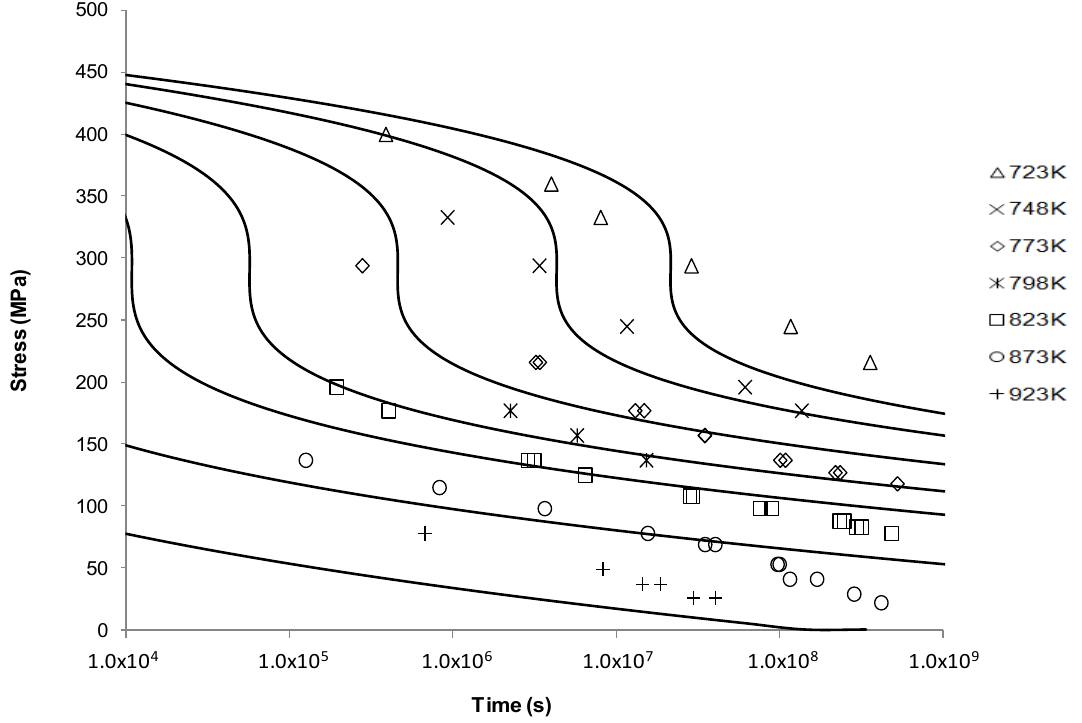
Figure 3. The Manson-Haferd’s stress vs . time to fracture predictive curves using Grade 22 Steel creep data.